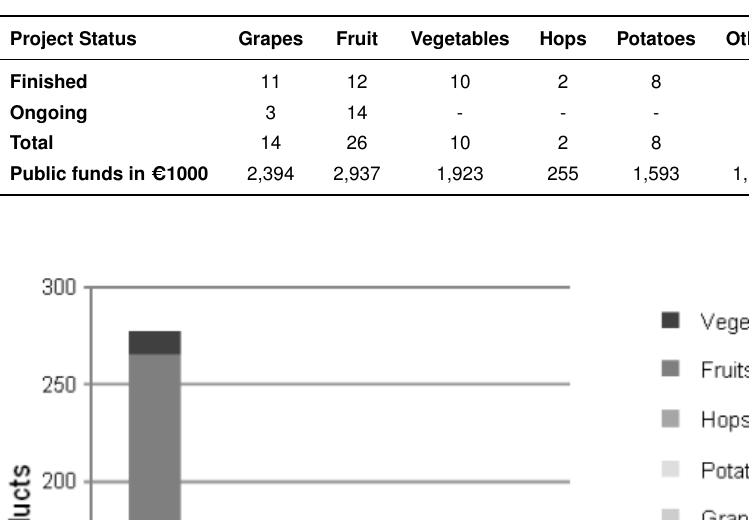
Table 10. Amount of funding from the “Federal Organic Farming Scheme and other forms of sustainable agriculture” (B ¨OLN) for research on the minimization and replacement of copper pesticides in Germany (from 2001 to 2015) by crop type.